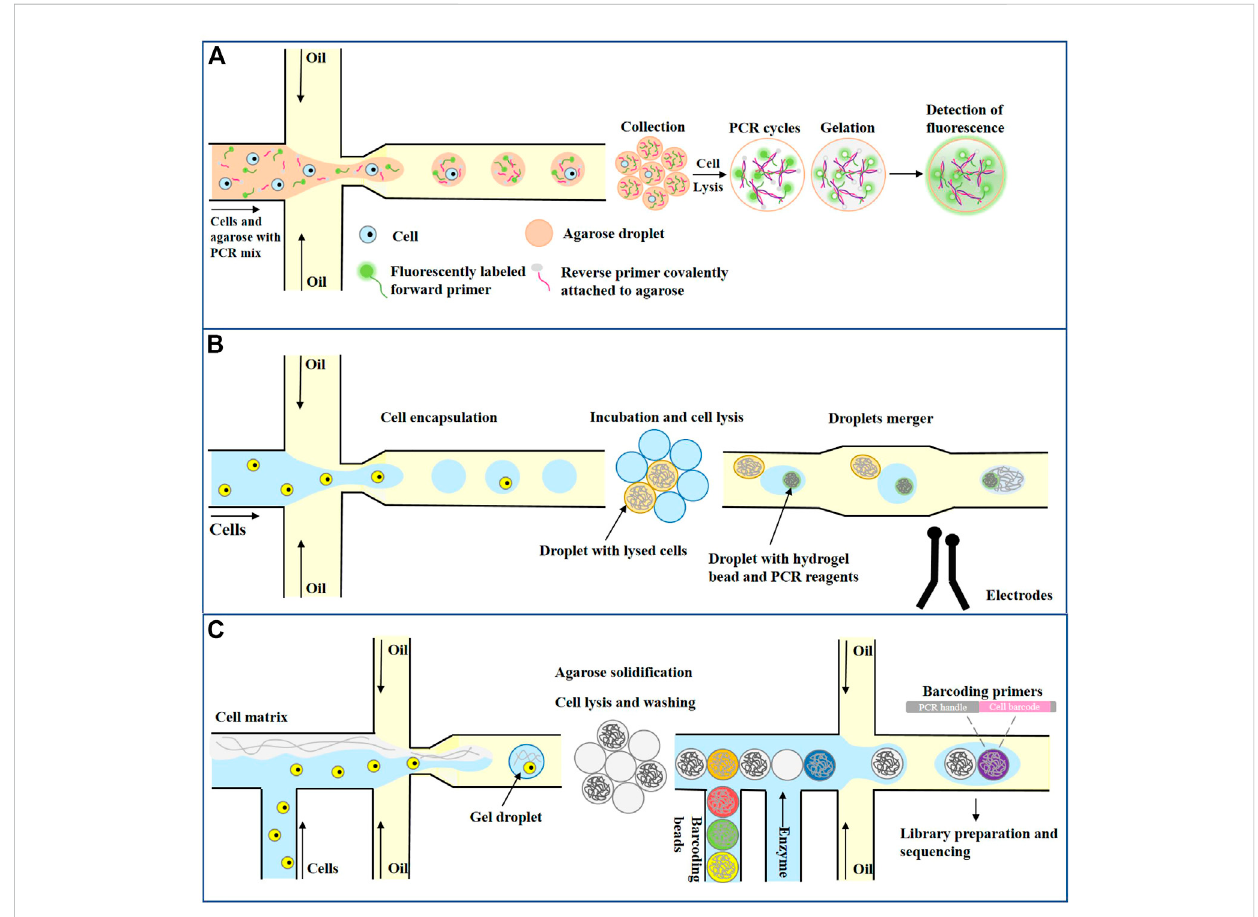
FIGURE 7 Droplet micro fl uidics for Single cell genomics analysis. (A) Single-cell PCR for emulsions based on agarose gel droplets (Zhu et al., 2012). (B) Single lactate-producingcyanobacterialcellsareencapsulatedin10 pLdroplets.Followinglactateproductionthroughincubation,anassayisperformedwhere thedropletsareinjectedwithanenzymethatcatalyzestheactivationofa fl uorescentdyeinthepresenceoflactate.Thedropletsareclassi fi edaccording to the fl uorescence signal (Pellegrino et al., 2018). (C) Single Cell Copy Number Variation (Andor et al.,